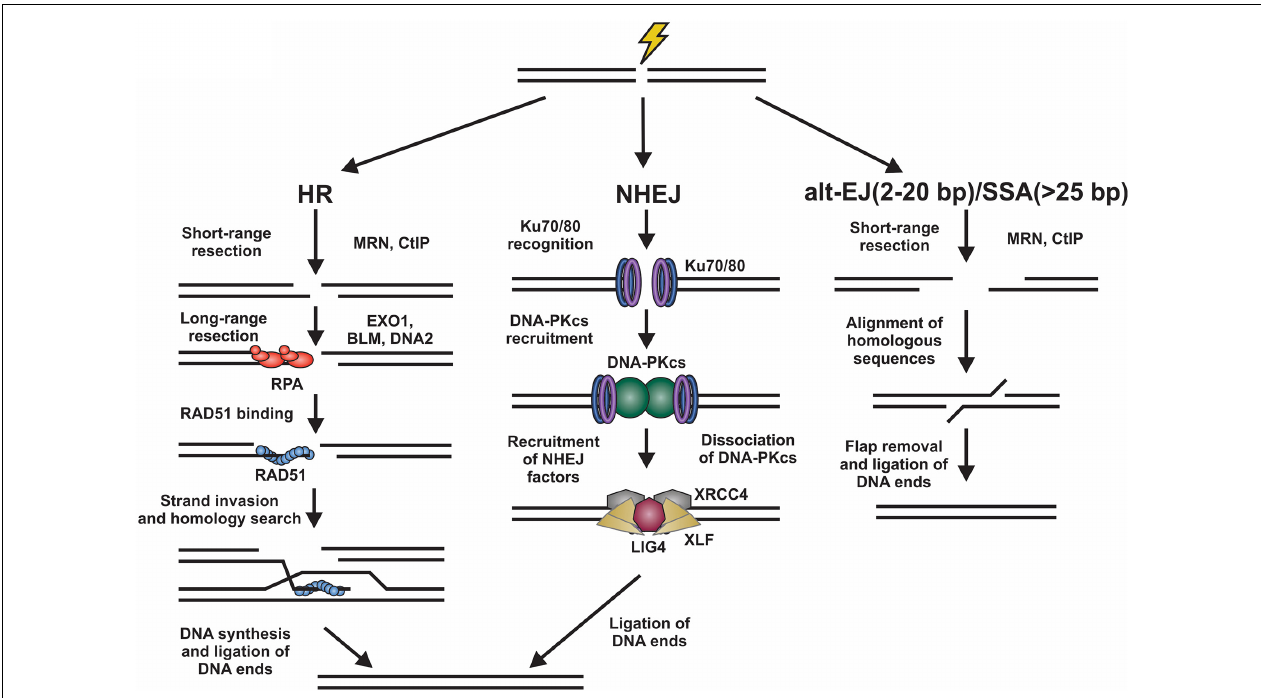
FIGURE 1 | Overview of DSB repair pathways. Left, homologous recombination (HR) involves resection of the DNA ends by various nucleases. The ssDNA generated is then bound by RPA. Next, there is an exchange of RPA for RAD51, which facilitates the homology search and repair of the DSB. Center, for non-homologous end joining (NHEJ), the DNA ends are bound by Ku70/80 heterodimers promoting the binding of DNA-PKcs. This creates a binding platform for XRCC4, XLF, and LIG4, which facilitate ligation of the DNA ends. Right, DSBs can also be repaired by alternative-end joining (alt-EJ) or single strand annealing (SSA) pathways. These involve the use of short homologous sequences that are exposed by resection of the break. Following alignment, the DNA flaps are removed and the DNA ligated. Alt-EJ uses around 2 to 20 base pairs (bp) of homology and SSA > 25 bp to align